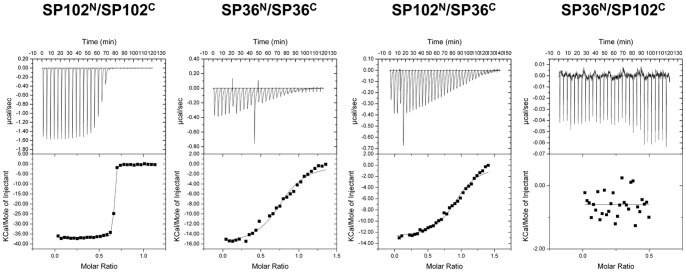
ITC measurement representing the desired specificity of the following combinations of the N- and C-termini of inteins: SP102N/SP102C, SP36N/SP36C, SP102N/SP36C and SP36N/SP102C (from left to right).